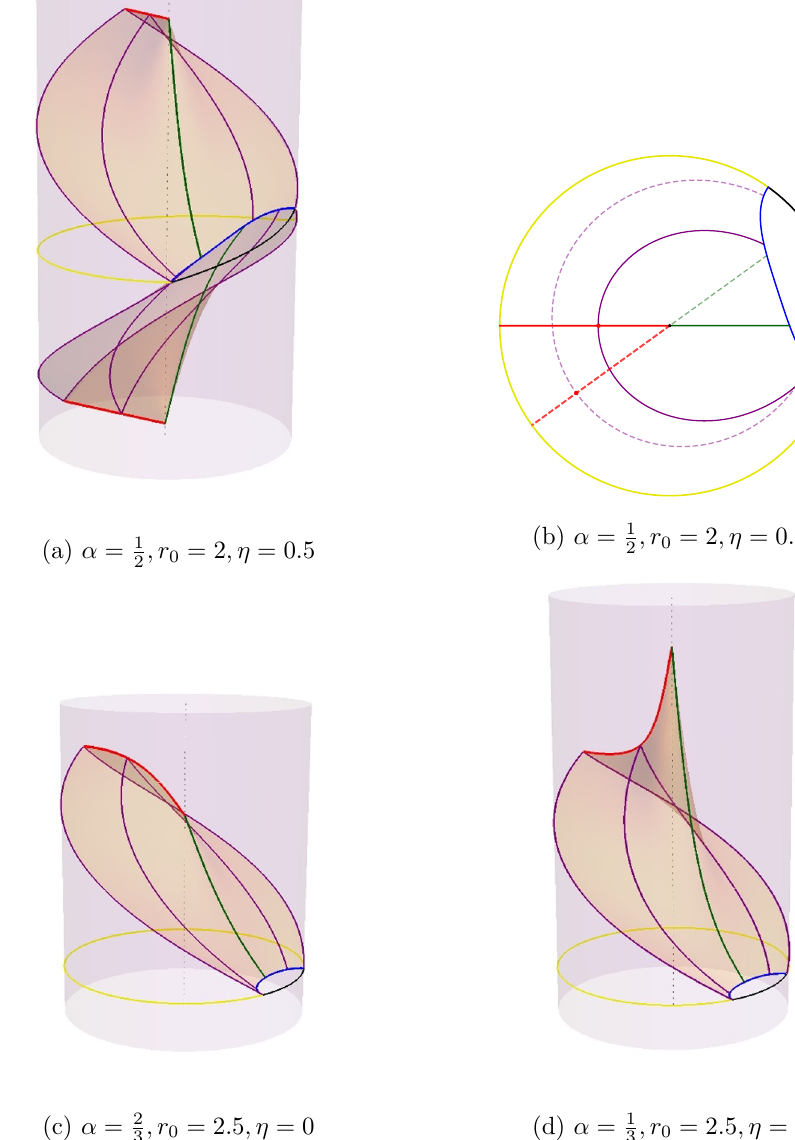
Figure 3. Plots of the lightsheet bounding the entanglement wedges corresponding to intervals, shown in yellow, that cover more than half of the boundary. The HRT surface is displayed in blue. A few light rays generating the lightsheet are drawn in purple. The light ray that hits the conical singularity at r = 0 is drawn in green and the caustic where the lightsheet terminates is in red. In (a) and (b) the front and top view respectively of the full lightsheet which bounds the entanglement wedge of a non-equal time slice HRT surface is displayed, with the dashed lines in (b) referring to the past lightsheet and the solid lines to the future lightsheet. For (cid:11) = 1 , the caustic is at constant 2 t . In (c) and (d) only the future lightsheet is displayed, so as to reduce clutter.